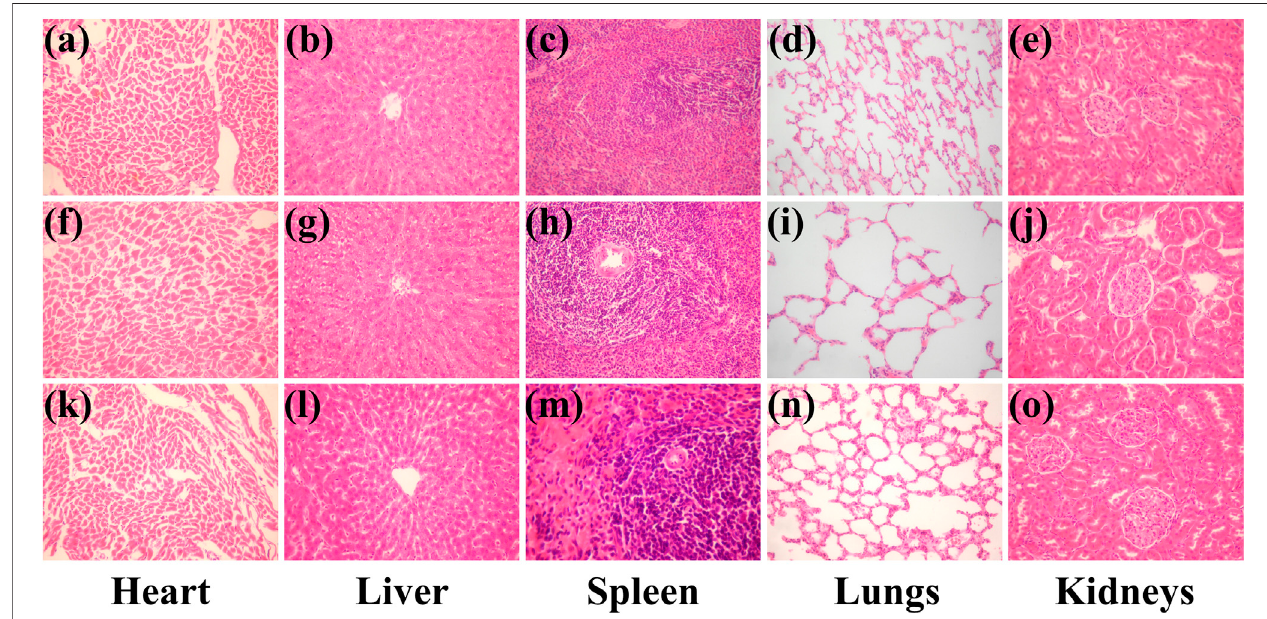
FIGURE 7 | H&E-stained primary organ slices 3 months after the surgery. (A – E) Control group; (F – J) PAM-SA hydrogel group; (K – O) composite group. Magni fi cation: 200 times.